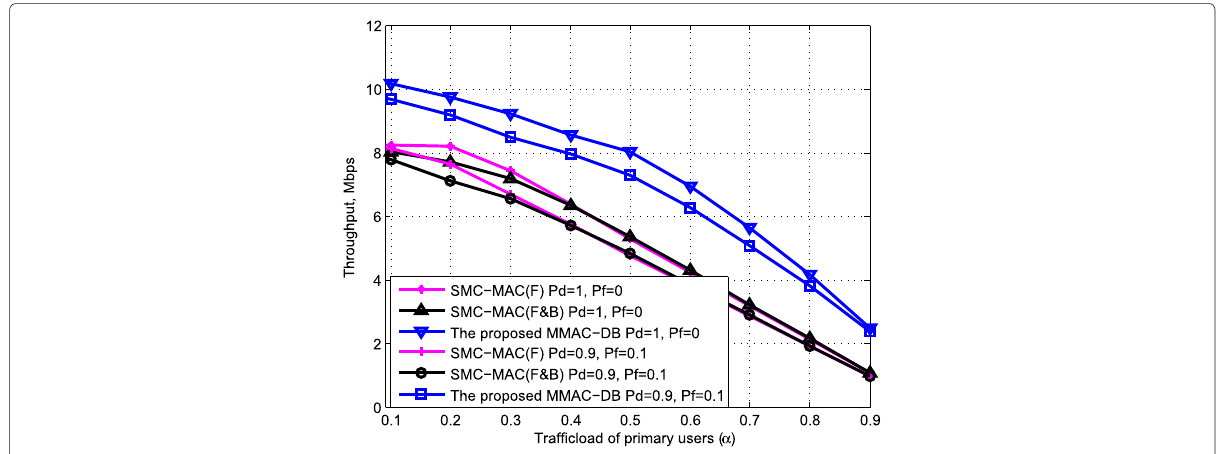
Fig. 7 Throughput comparison with varying PU traffic load, N = 20, M = 20, K f = 50. Throughput comparison for scene 1